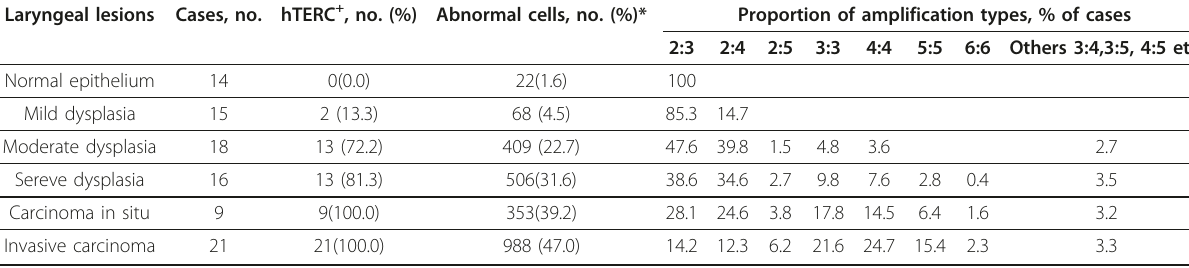
Table 1 hTERC Amplification According to Histopathologic Evaluation Laryngeal lesions Cases, no. hTERC + , no. (%) Abnormal cells, no. (%)*